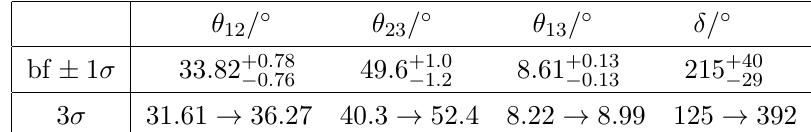
Figure 6 . Parameter space of CP (cid:22)(cid:28) symmetric mass matrix within a two RH neutrino scenario: x 1 vs x 2 (left) and y 1 vs y 2 (right), where these dimensional parameters (in p eV) are de(cid:12)ned in eq. (2.13).